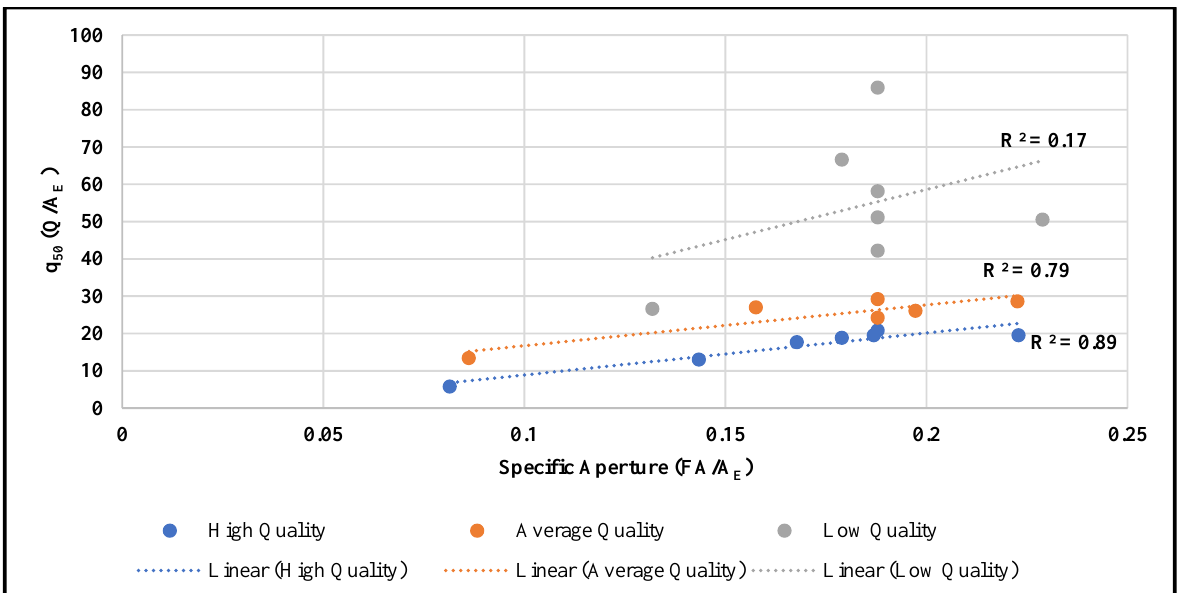
Figure 13. Linear correlation between q 50 and specific aperture across the three different observed categories of observed fenestration quality.